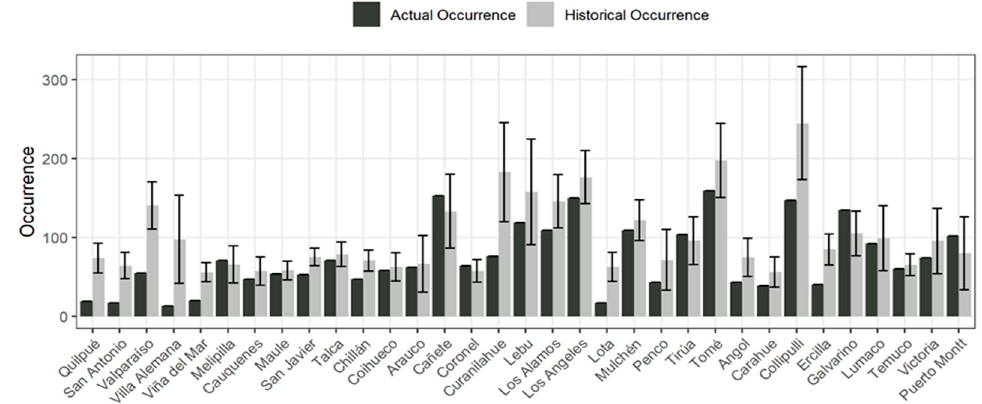
Figure 3. Occurrence Lockdown and historical. Communal scale. Period 15 March 2020–15 March 2021.